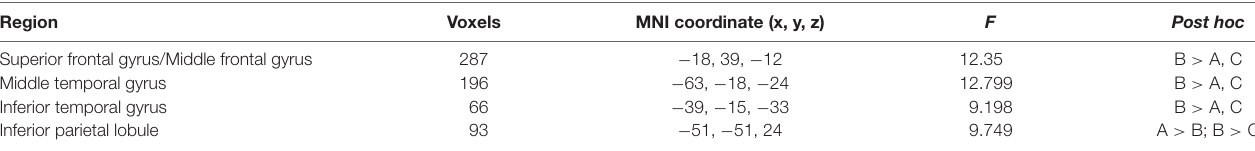
TABLE 2 | Regions showing between-group differences in fALFF.